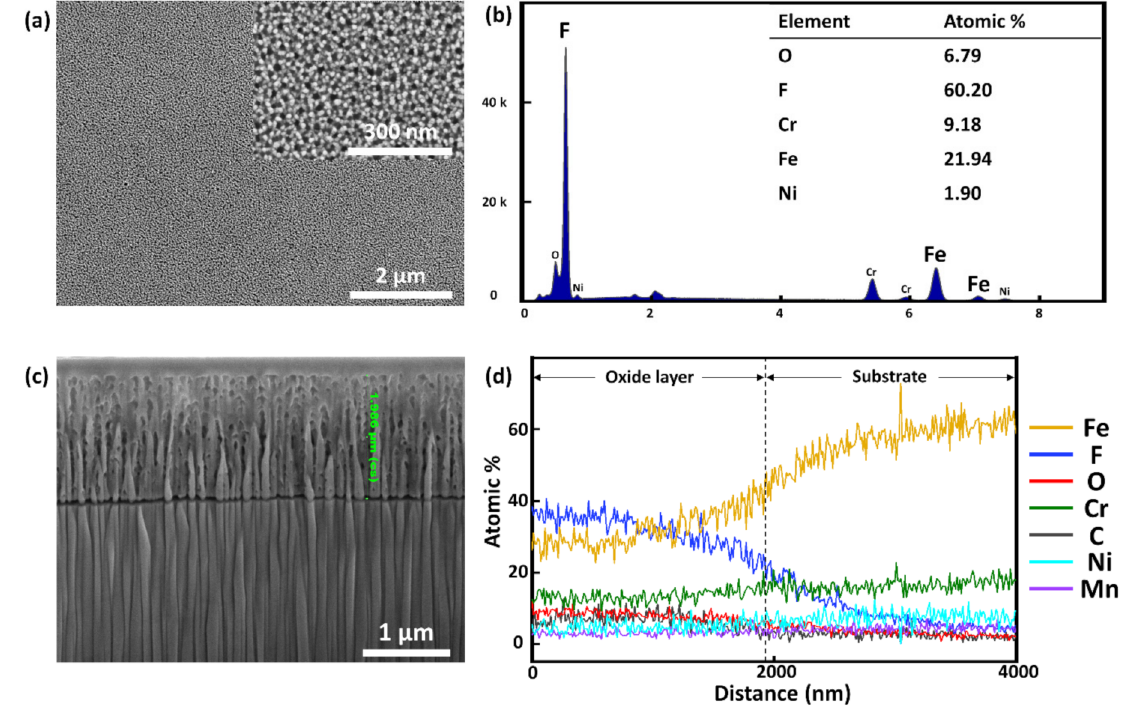
Figure 4. FESEM images showing surface morphologies of anodized welded SS at low and high magnification ( a ) and EDX characterization of the surface ( b ). Cross-sectional FESEM image of anodized welded SS ( c ) and EDX line spectrum of the cross section ( d